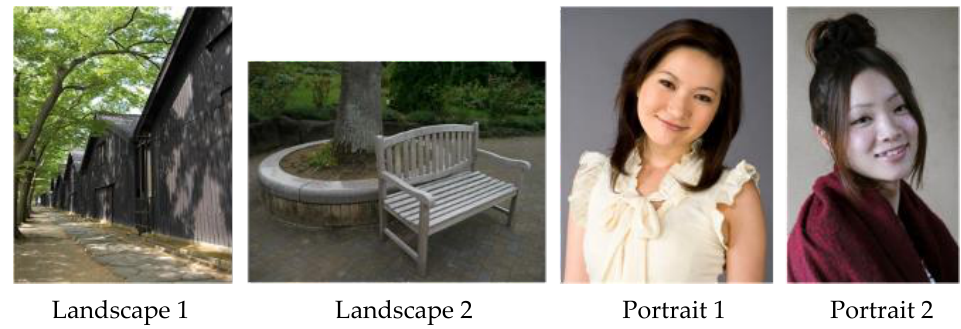
Figure 3. The original digital photos for stylized migration.